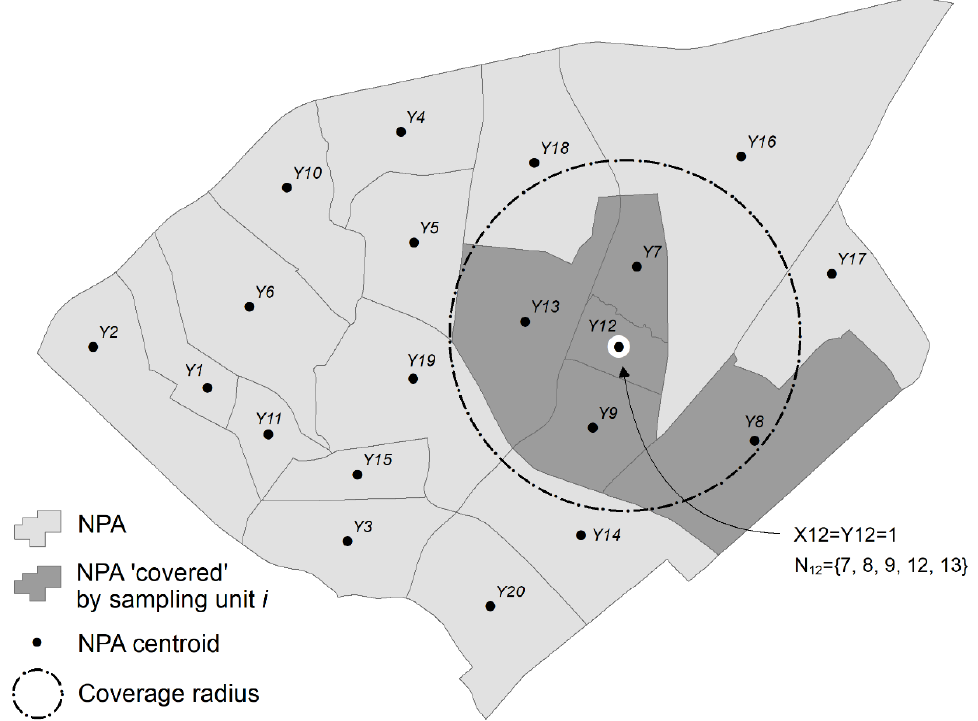
Figure 5. Illustration of Phase 2 mechanism in the optimization procedure. If a sampling unit at i = 12 is selected, it will “cover” neighborhoods j = 7, 8, 9, 12 and 13. Table 1. Quintile ranges for each of the nine variables used in the optimization process and number of sample points within each range.